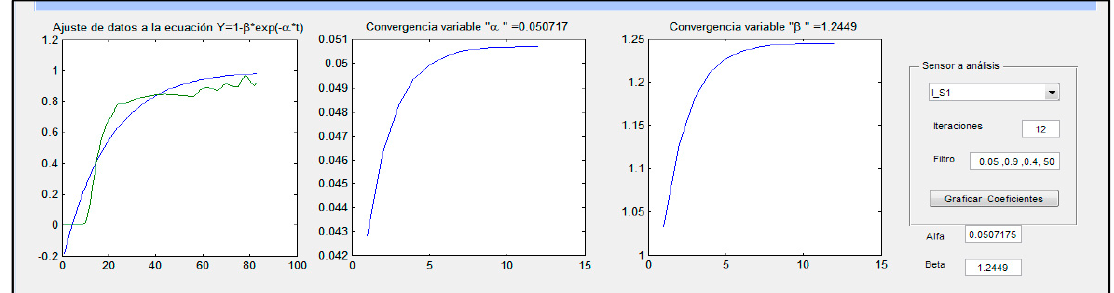
Figure 10. Software interface of to show the example of adjustment of data of temperature and humidity to the exponential curve. This adjustment was made by the nonlinear iterative Gauss-Newton method.